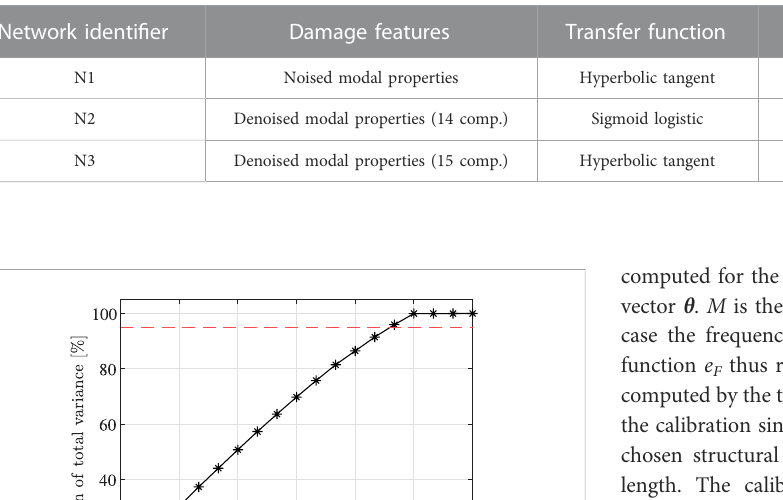
TABLE 3 Numerical case study: studied networks and their optimal architecture.